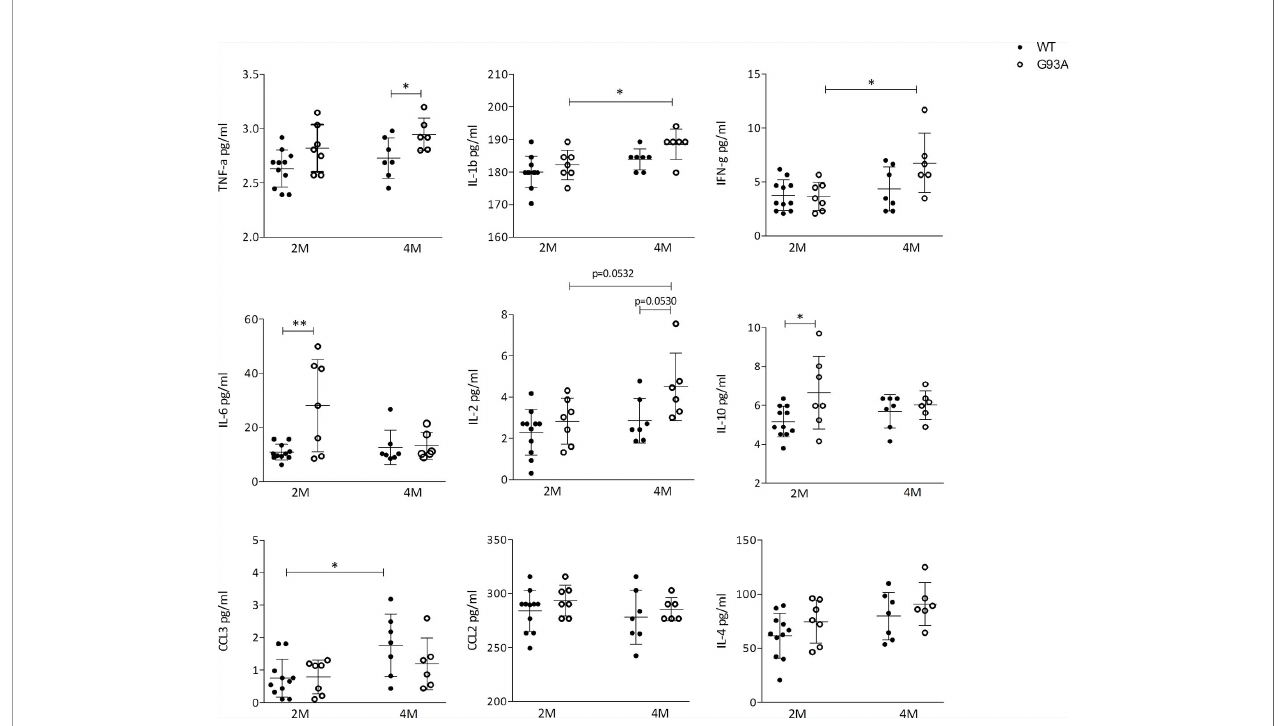
FIGURE 6 | Cytokines production in WT and G93A mice serum. Graphs showing the level of: TNF- a IL-1 b ; IFN- g ; IL-6; IL-2; IL-10; CCL3/MIP-1 a CCL2/MCP-1 and IL-4 in serum of 2 months (n = 11) and 4 months (n = 7) WT mice and 2 months (n = 7) and 4 months (n = 6) SOD1-G93A+ mice. p values are calculated with unpaired t-test: *p < 0.05; **p <